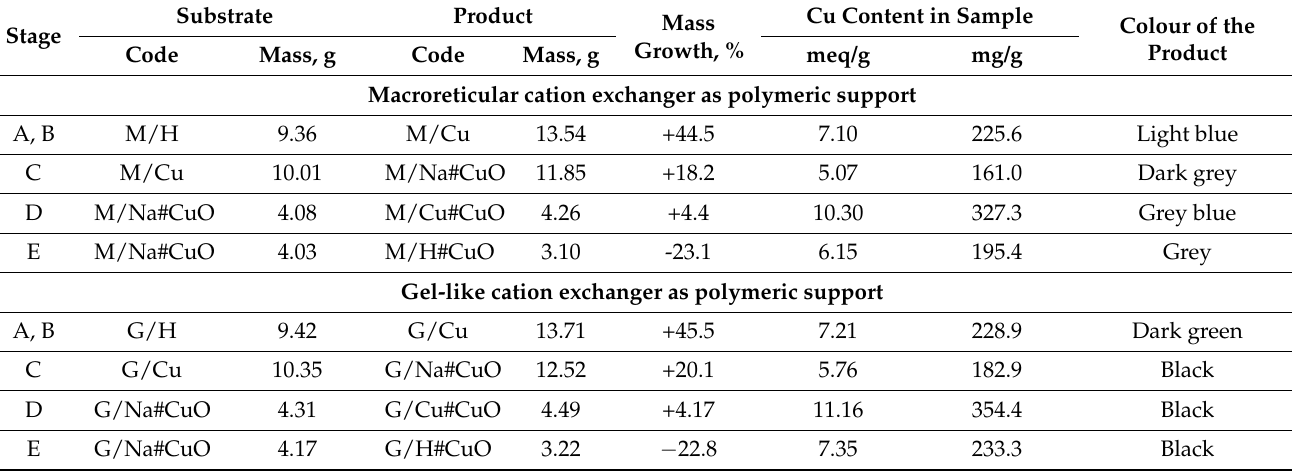
Cu Content in Sample Colour of the Growth, %